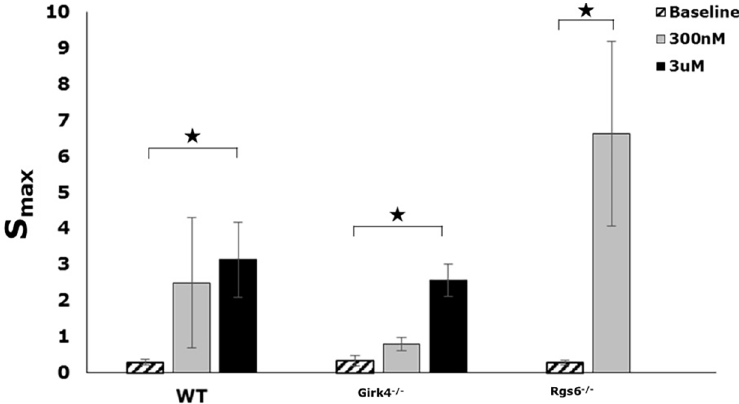
Fig 3. The effect of GIRK4 and RGS6 ablation on S max . Summary of the baseline and post-CCh maximum slopes of APD restitution, S max , in WT (n = 8), Girk4 -/- (n = 8) and Rgs6 -/- (n = 5) mice. (‘ (cid:3) ’ denotes statistical significance of p < 0.05 between post-CCh and baseline for the same genotype. Statistics performed using 1-way ANOVA).